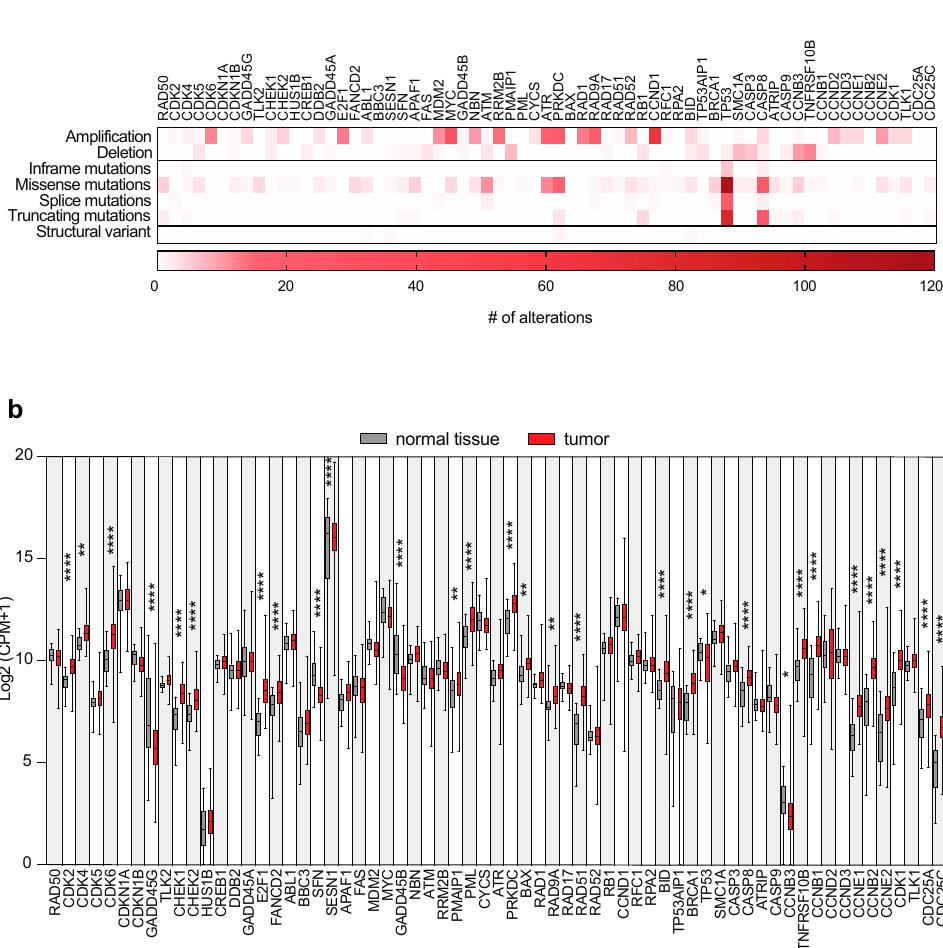
Figure 1. Genomic alterations and expression of DDR genes in human OSCC tumors. ( a ) Heatmap depicting the number of genomic alterations of 65 DDR genes (Supplementary Table S2) in 316 OSCC tumor samples from the TGCA Pan-Cancer Atlas (Supplementary Table S1). ( b ) Box plots depicting RNA-seq analysis of DDR gene expressions in 316 OSCC tumors from the TCGA Pan-Cancer Atlas, and 32 matched normal samples (Supplementary Table S3). One-way ANOVA for multiple comparisons. * p < 0.05, ** p < 0.01, **** p < 0.0001. Groups without statistical significance were unmarked. CPM; counts per million mapped reads.